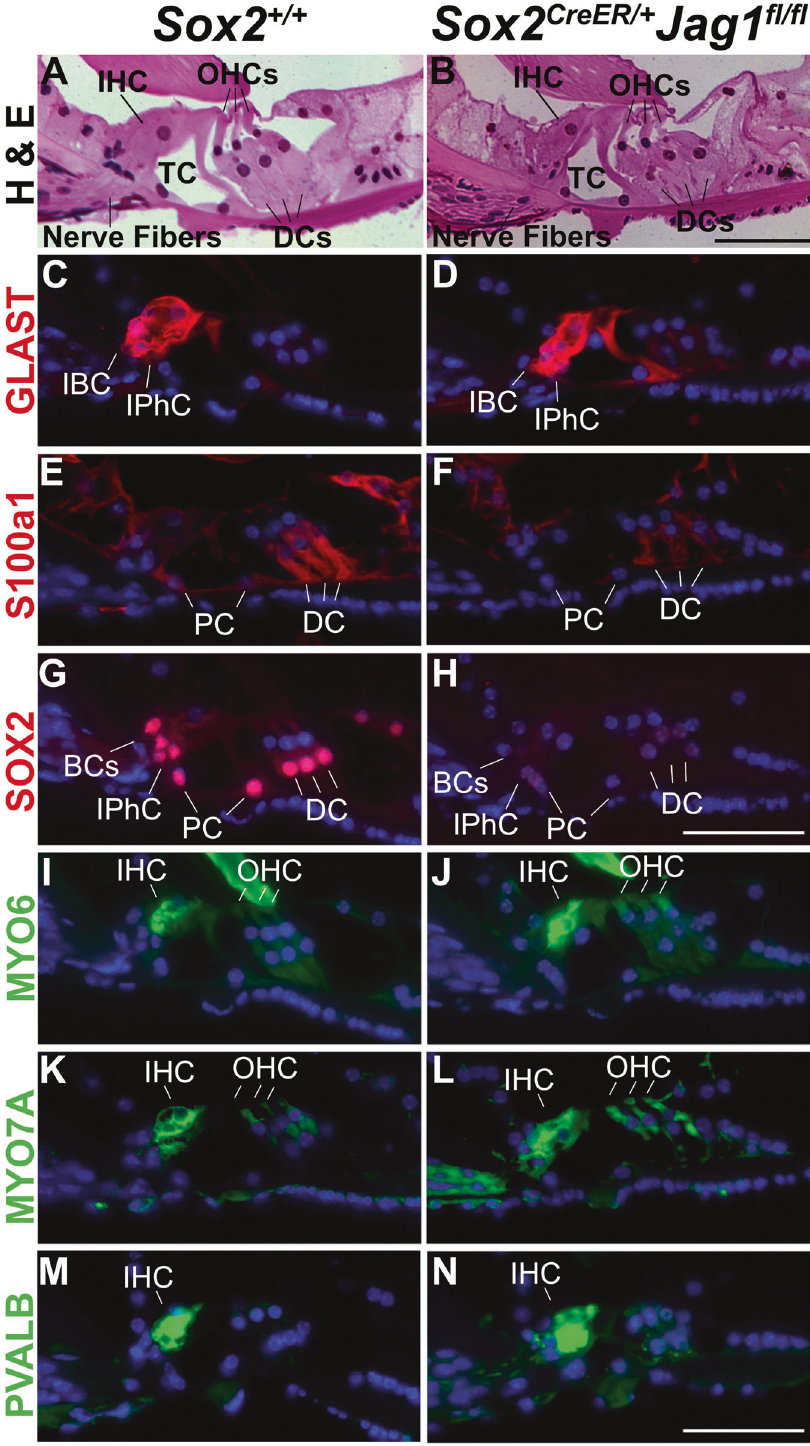
inner hair cell pathway was disrupted in JAG1-de fi cient mice, and are consistent with AUNA1 mouse models that displayed fused stereocilia bundles, caused by overexpression of Diaph3 . DISCUSSION During embryonic inner ear development, the Notch ligand JAG1 plays an established role in prosensory region speci fi cation